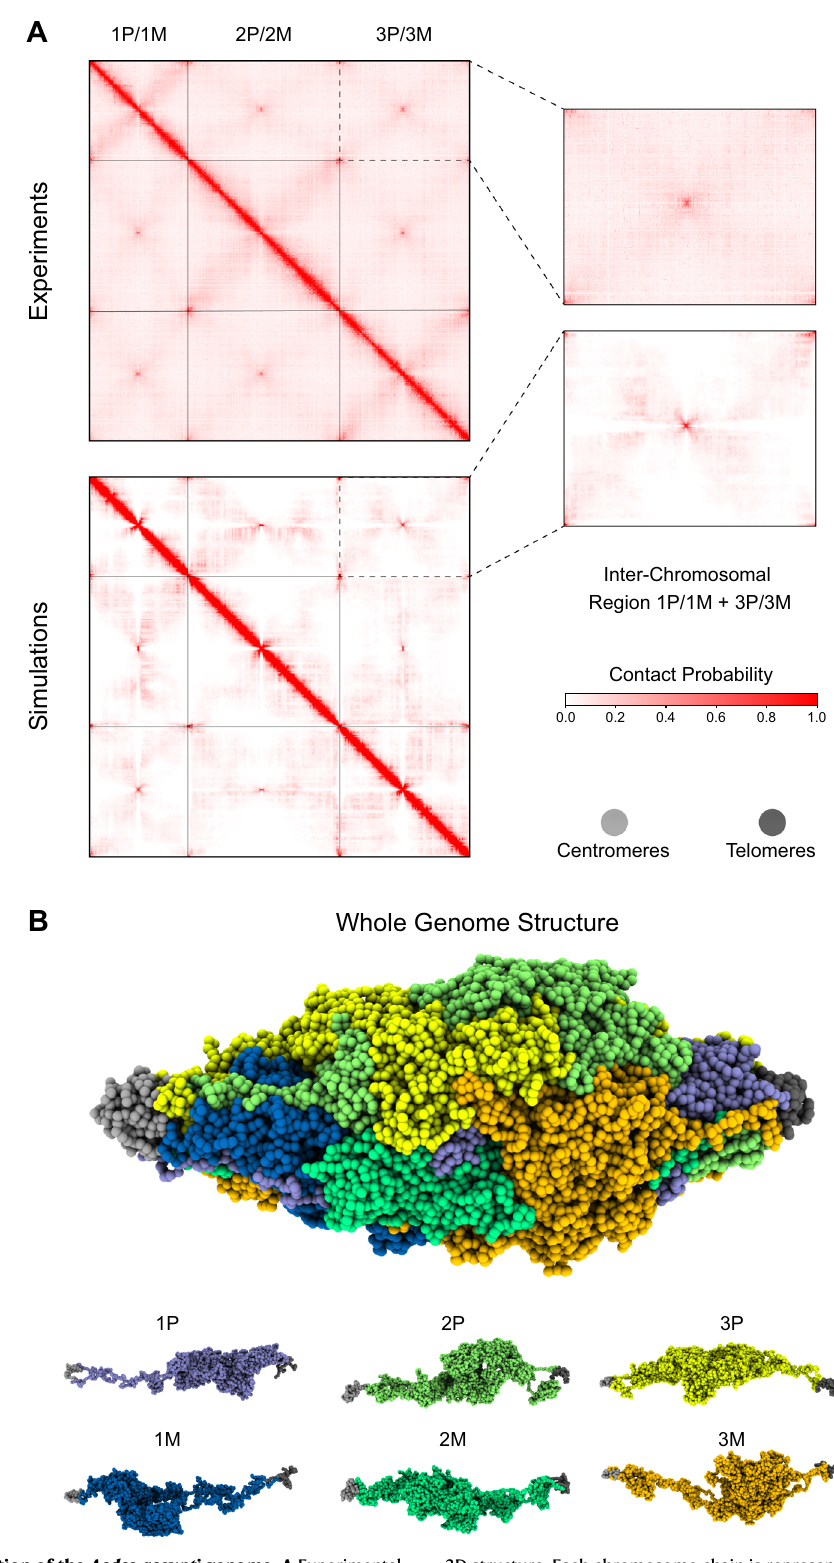
3D structure. Each chromosome chain is represented by a unique color. Cen- tromeres are represented by ligth gray beads (left) and telomeres by dark gray (right). The 3D structure highlights the formation of elongated territories in the Aedes aegypti